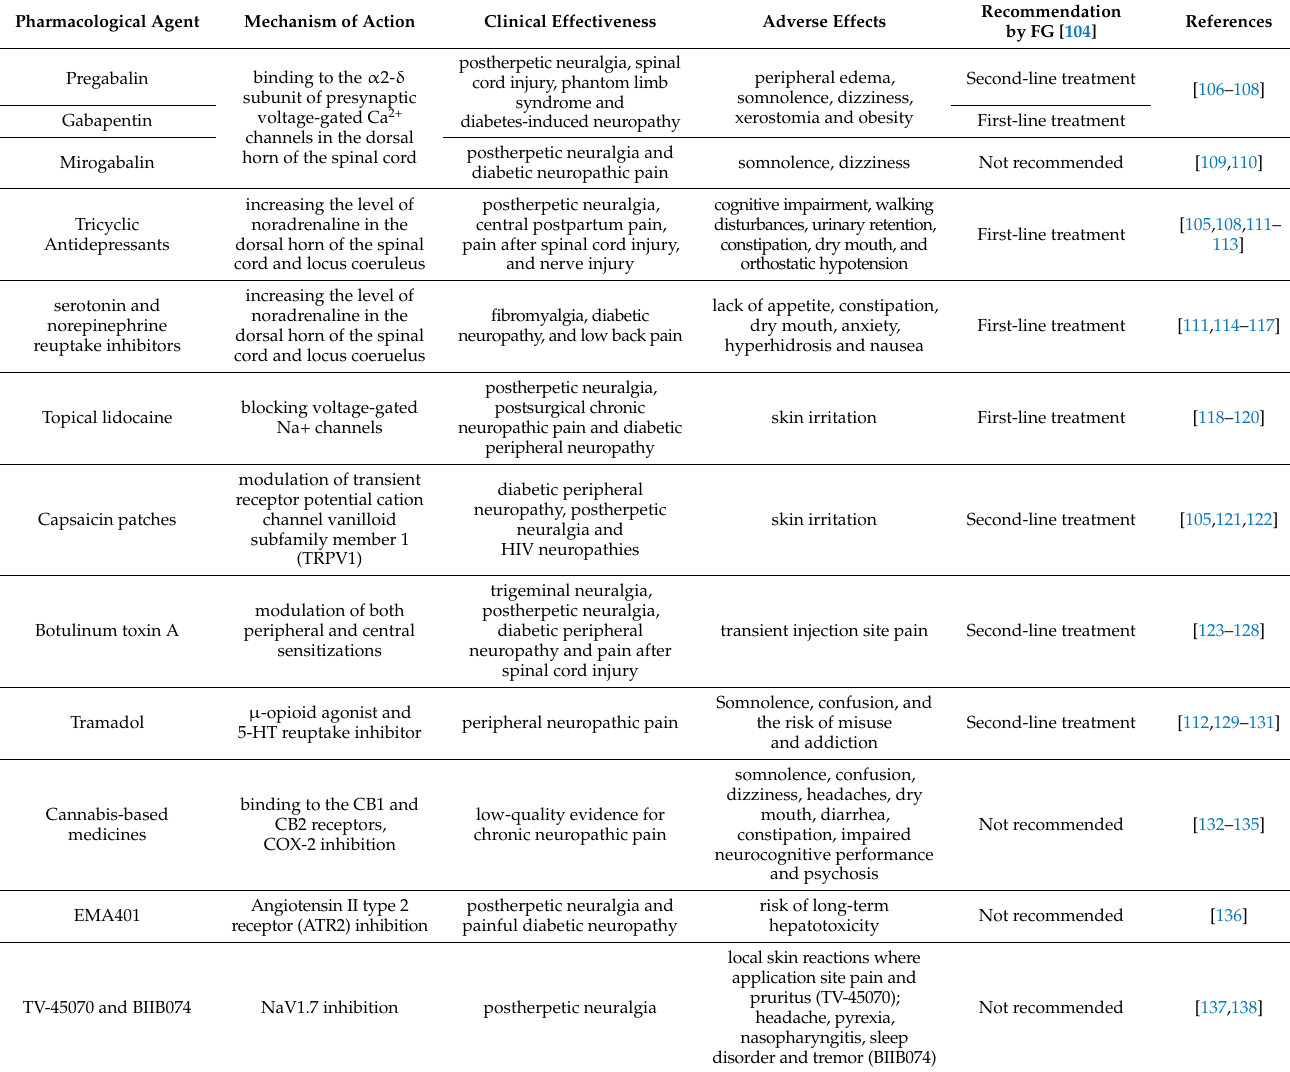
Table 2. A summary of currently available pharmacological agents for neuropathic